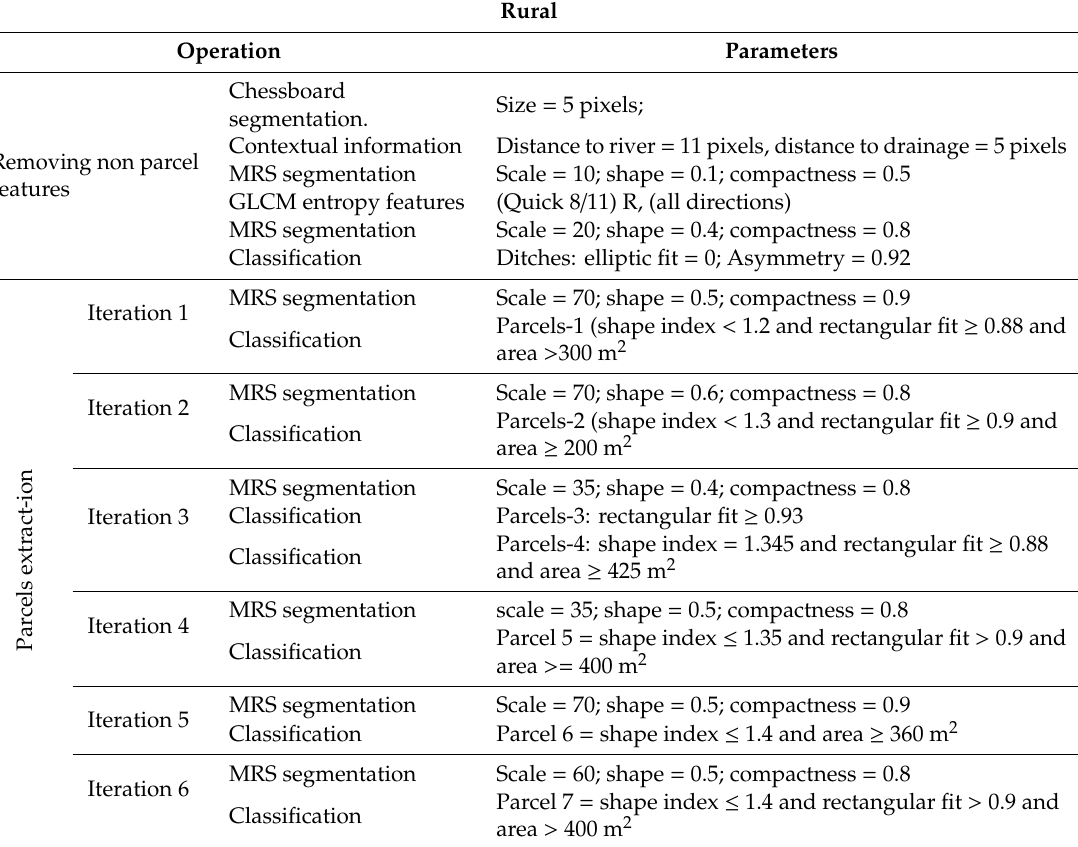
Table 1. Parameter tuning with different steps followed in rule sets.